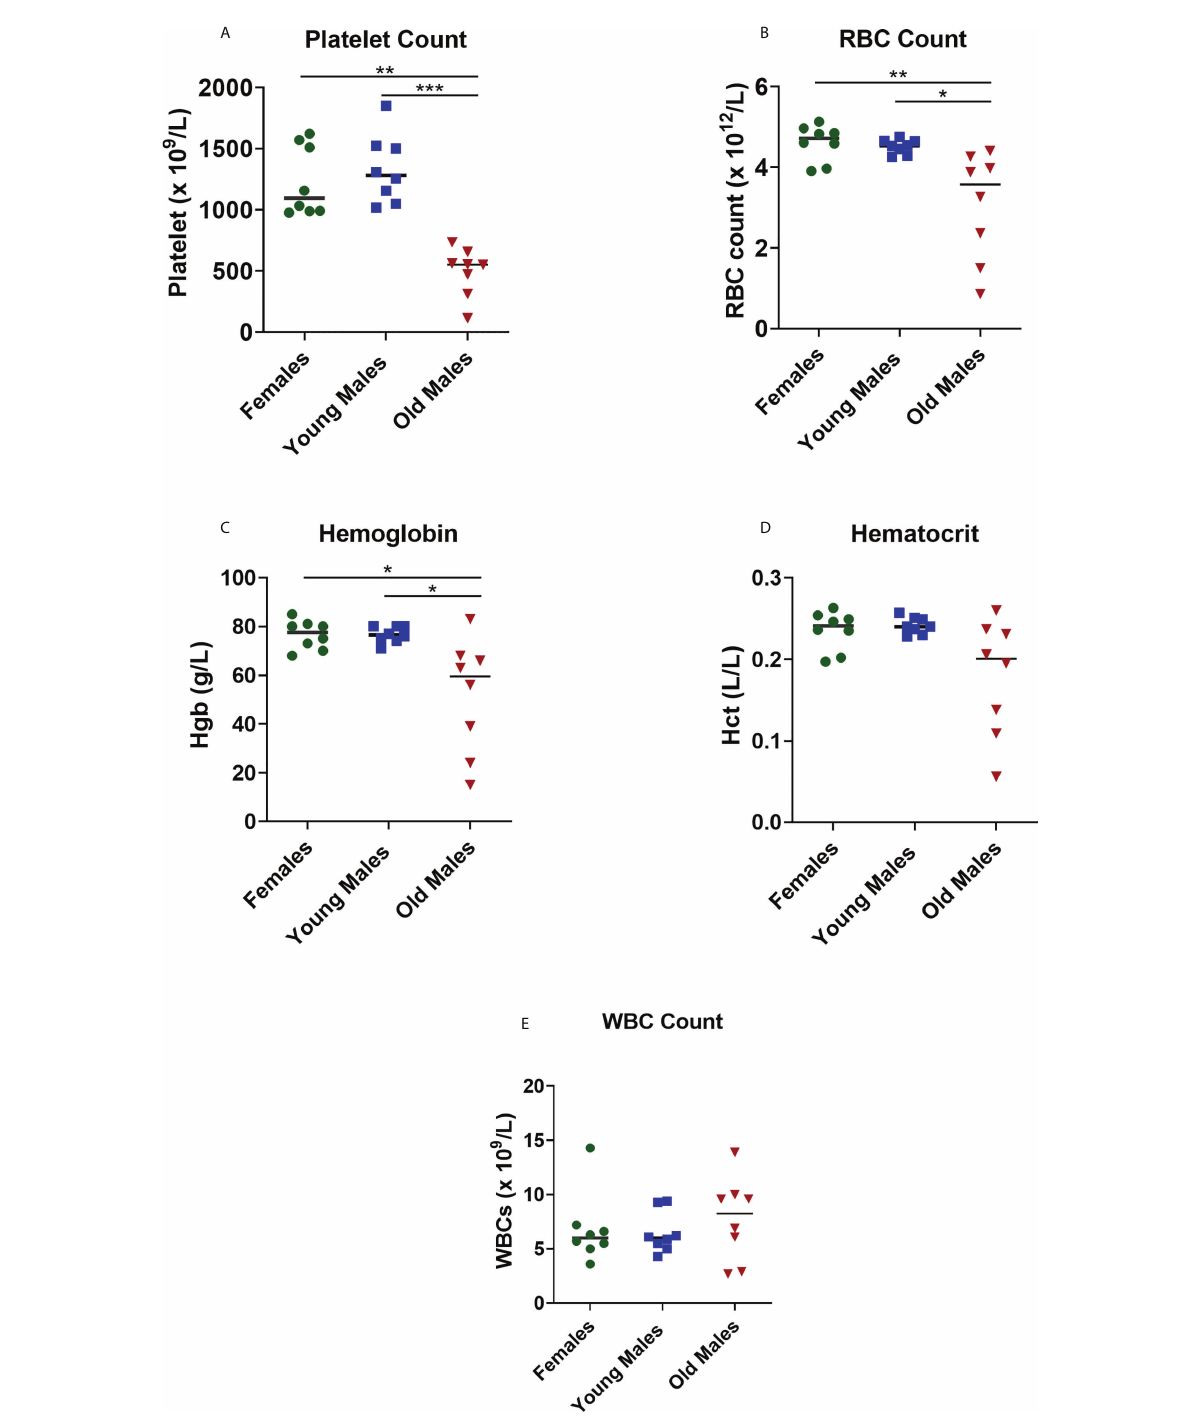
FIGURE 3 Changes in the blood cell parameters of the NZW/LacJ x BXSB/MpJ 9 F1 lupus mice. Platelets (A) , red blood cells (B) , hemoglobin (C) , hematocrit (D) , and WBC (E) were measured in female (green circle dots), young/healthy males (blue square) and old sick males (red tringle). Data are presented as as scatter dot plot with median line; n= 8 per group. P < 0.05 were regarded as statistically signi fi cant. Signi fi cant level (*p < 0.05; **p < 0.01; ***p < 0.001) in comparison to